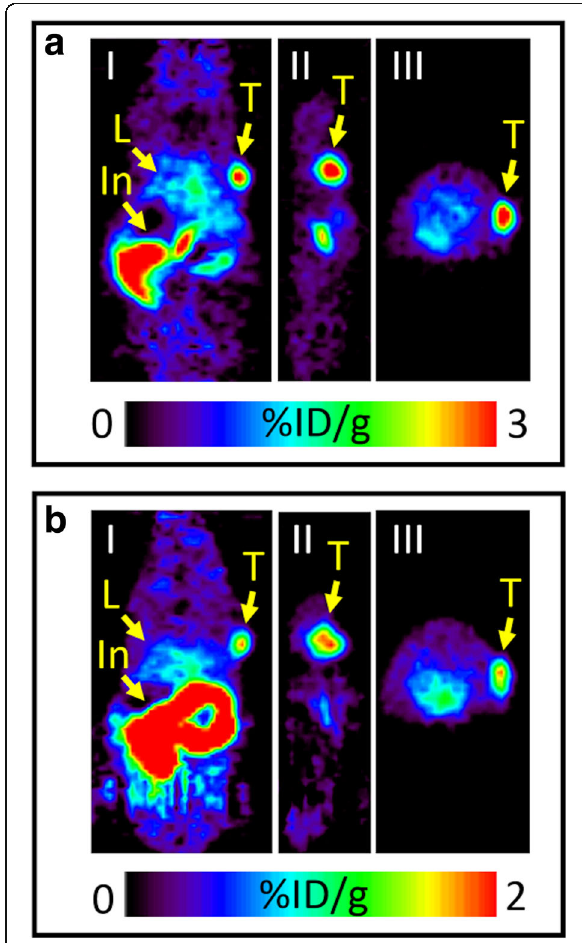
Fig. 4 PET images of pretargeted cetuximab in A431 tumour-bearing mouse in group A ( a ) and pretargeted trastuzumab in BT-474 tumour- bearing mouse in group A ( b ). a 75 μ g of TCO-cetuximab (3.1 nmol of TCO) was administered 72 h prior to the injection of [ 18 F]TAF